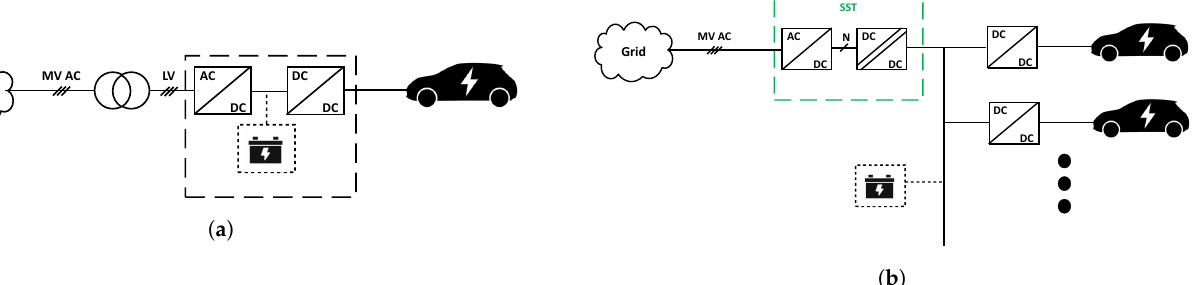
Figure 11. ( a ) Typical scheme of a multiport EV ultra-fast charger. ( b ) The alternative SST configura- tion. Black dots indicate multiple EV chargers connected in